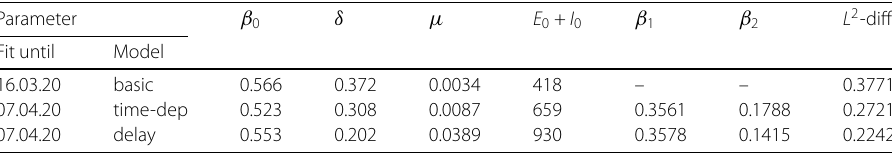
Table 1 Optimal parameter values for the three models (1a)–(1e), (3a)–(3e) and (4a)–(4e) obtained from the minimization problem (6a)–(6b) Parameter β 0 δ μ E 0 + I 0 β 1 β 2 L 2 -diff Fit until Model 16.03.20